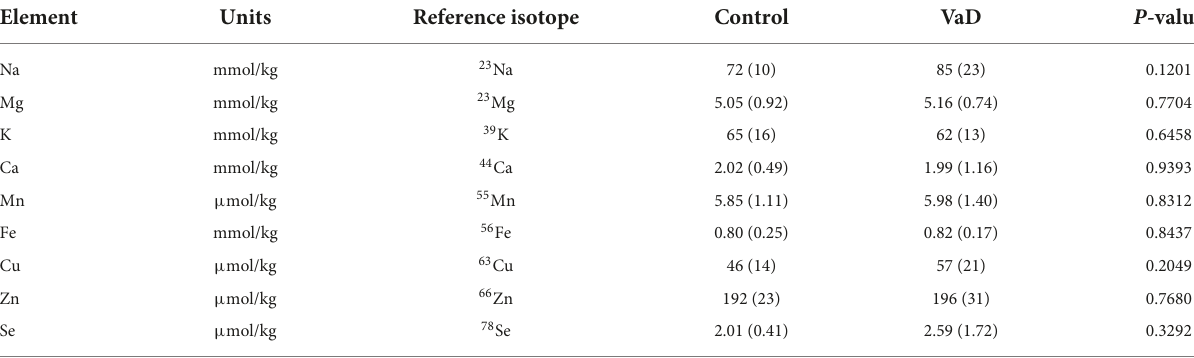
TABLE 5 Wet-weight metal concentrations in the thalamus of VaD and control brains. Element Units